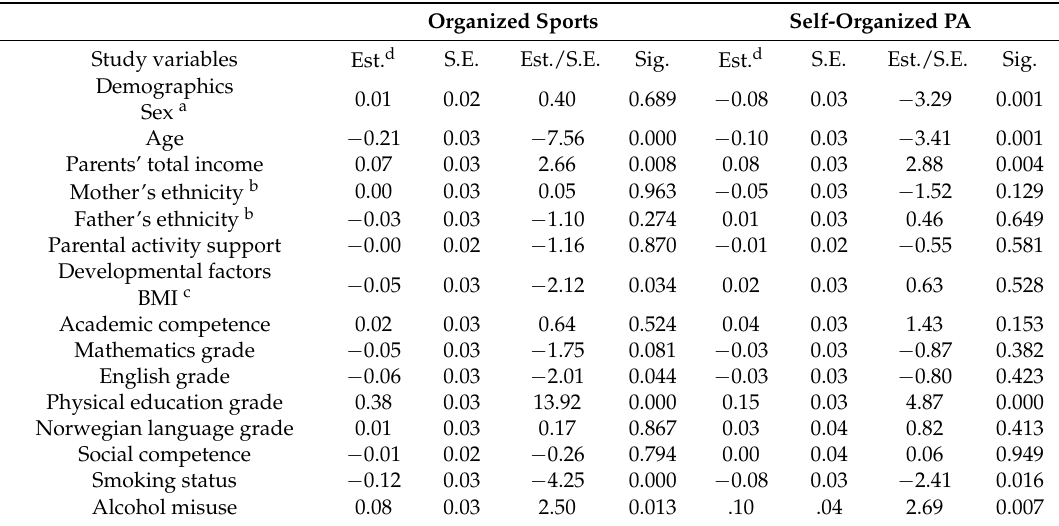
Table 3. Ordinal regression analyses of organized and self-organized physical